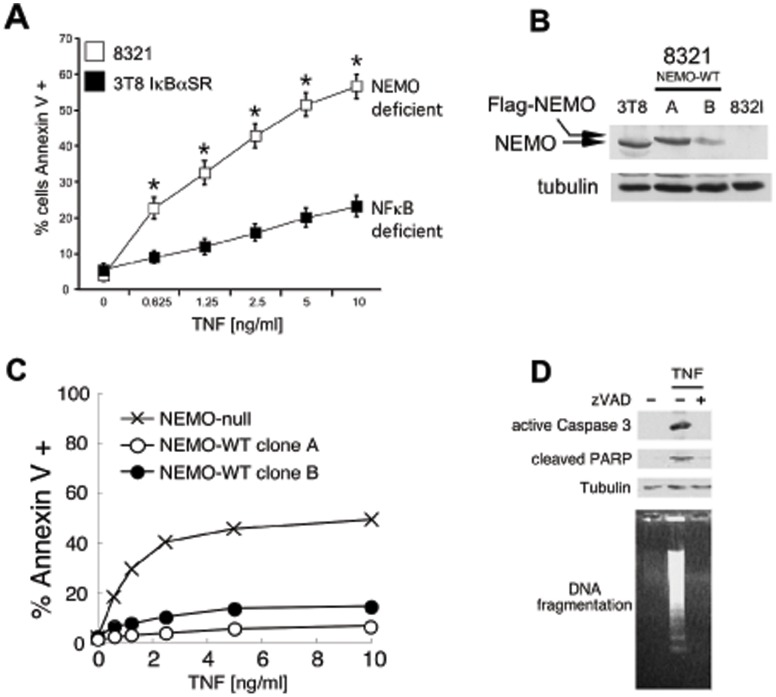
NEMO does not require NFκB to inhibit caspase-independent cell death.(A) NEMO-deficient (8321) cells and NFκB-deficient (3T8 IκBαSR) cells were co-incubated with 10 µM zVAD-fmk pan-caspase inhibitor and different doses of TNF for 24 h. Cell death was quantified by Annexin V staining and flow cytometry. The mean and SEM of six independent experiments is shown, * denotes p<0.05. (B) Immunoblot indicates the amount of NEMO protein expressed by the parental 3T8 cell line and the two reconstituted clones. (C) Reconstitution of NEMO-deficient cells with NEMO prevents caspase-independent cell death as shown by a TNF dose response of cell death (performed as described in (A) in two clones of NEMO-expressing cells compared to NEMO-deficient cells. (D) Immunoblot of SDS-soluble lysates from NEMO-deficient cells co-incubated with 10 µM zVAD and 10 ng/ml TNF for 24 h indicates that Caspase 3 and PARP cleavage does not occur in NEMO-deficient cells dying in the presence of pan-caspase inhibitor. Genomic DNA was electrophoresed and visualized with ethidium bromide. All cell lines shown in Figure 1 are unable to activate NFκB either due to NEMO deficiency or expression of the IκBαSR.